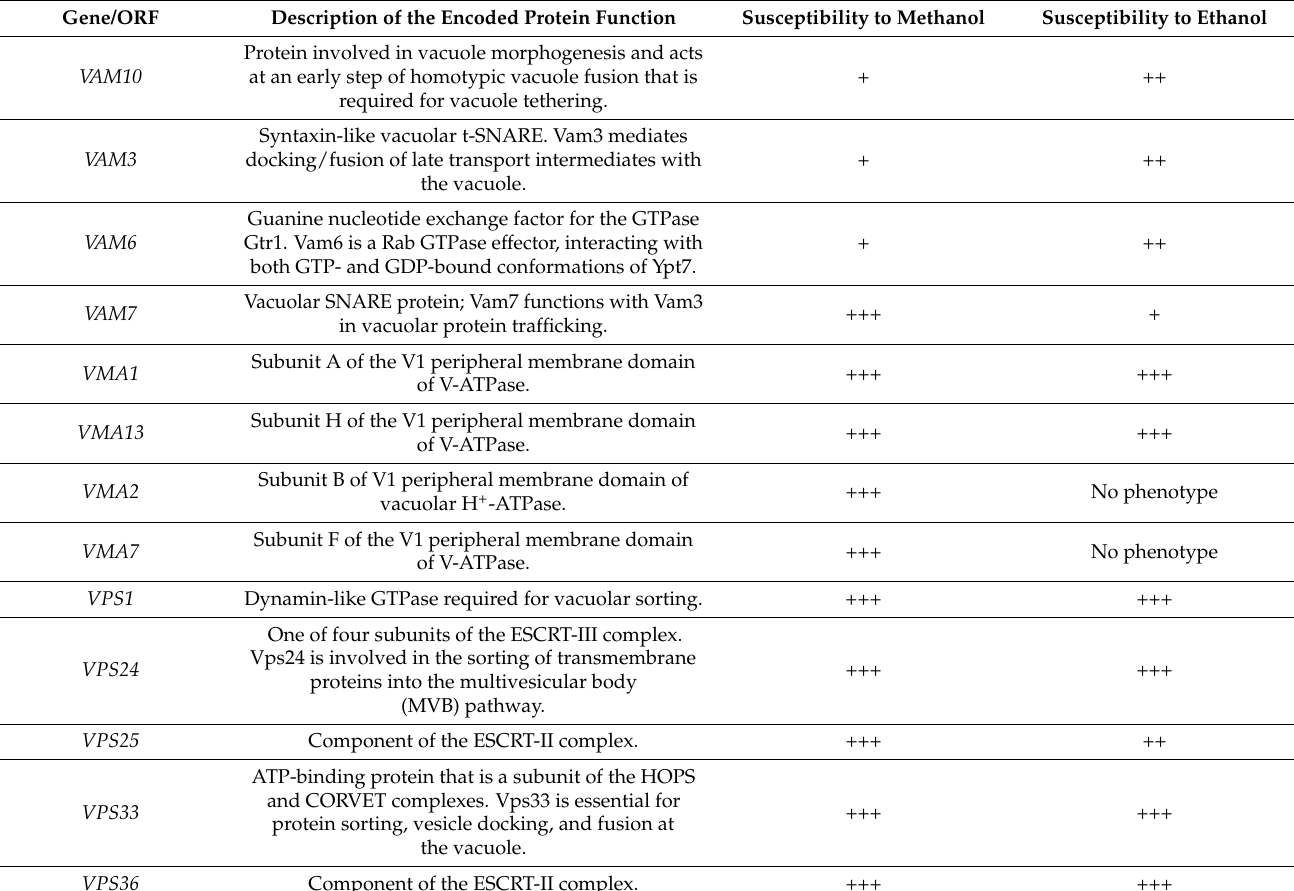
Table 4. Genes involved in vacuolar organization and acidification identified in this study as determinants of yeast tolerance to methanol, compared with ethanol. Symbols are as in Table 1.